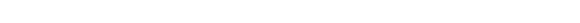
Table 1. Percent of PV, CR, SOM, VIP, NPY, CCK, NOS and ChAT immunolabeled neurons that coexpress GABA. The total number of cells is shown in parentheses.